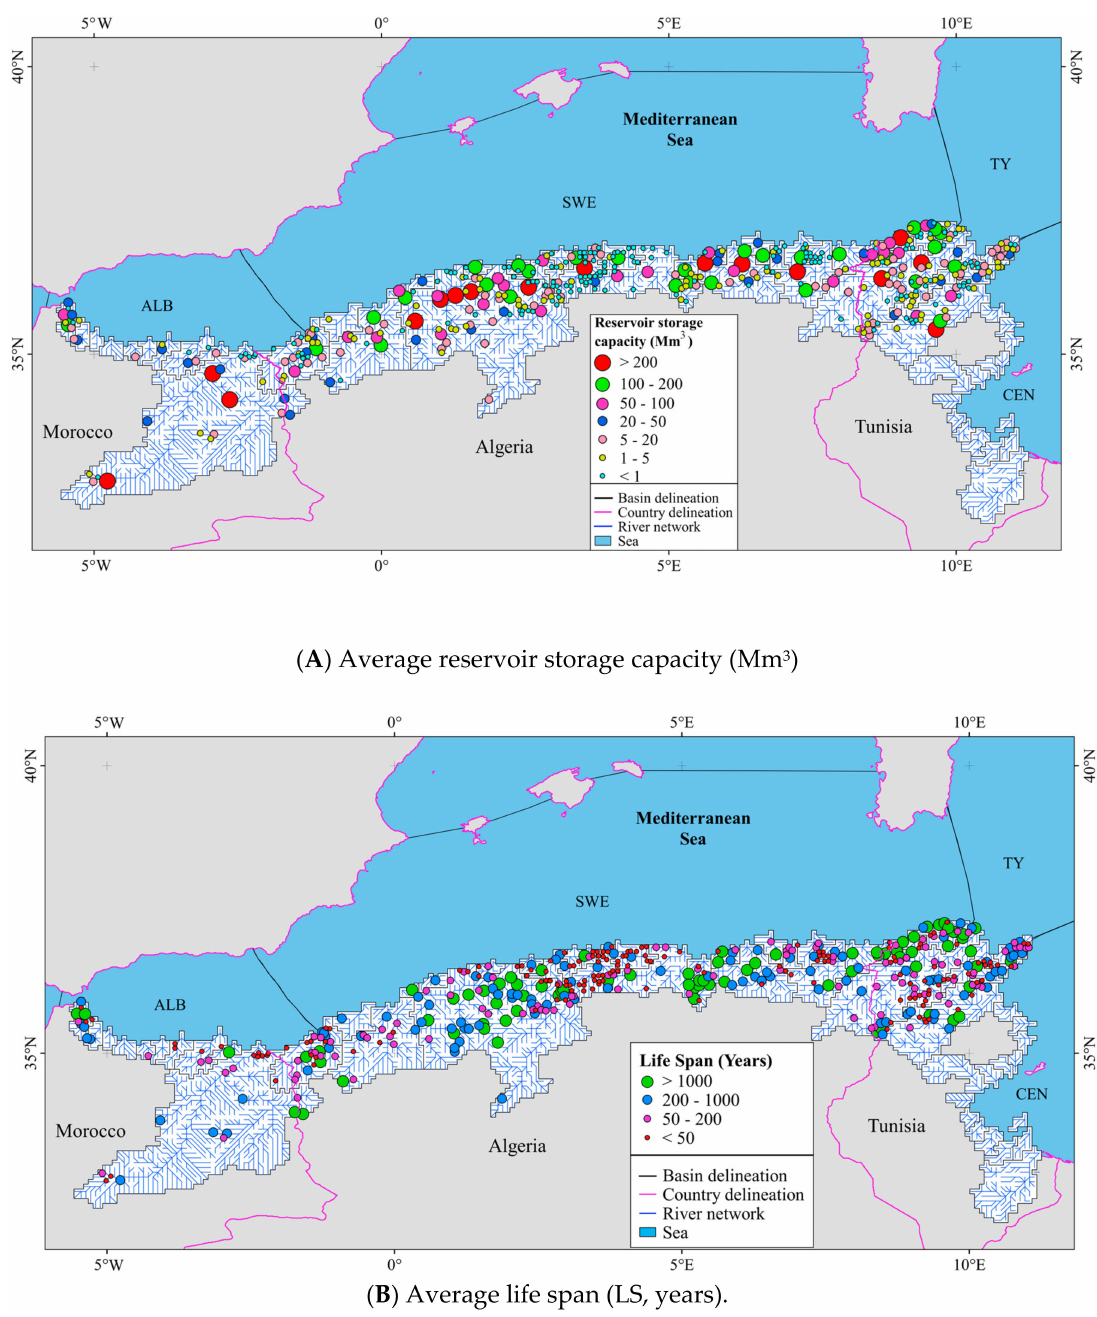
Figure 4. Geographical distribution of the 450 dams and hillsides implemented in the modeling part of this